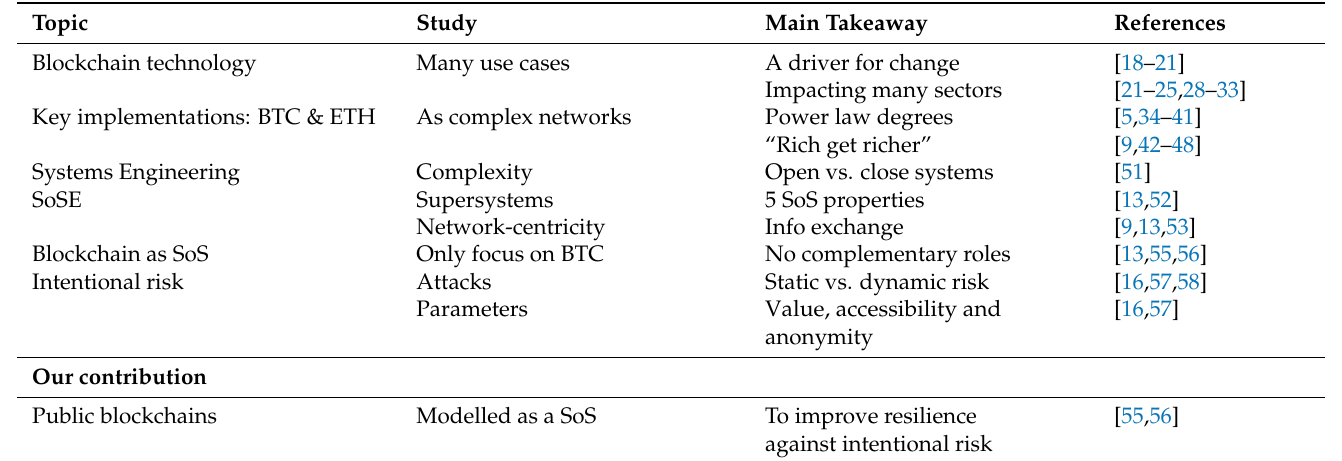
Table 2. The role that related works play to build our contribution.